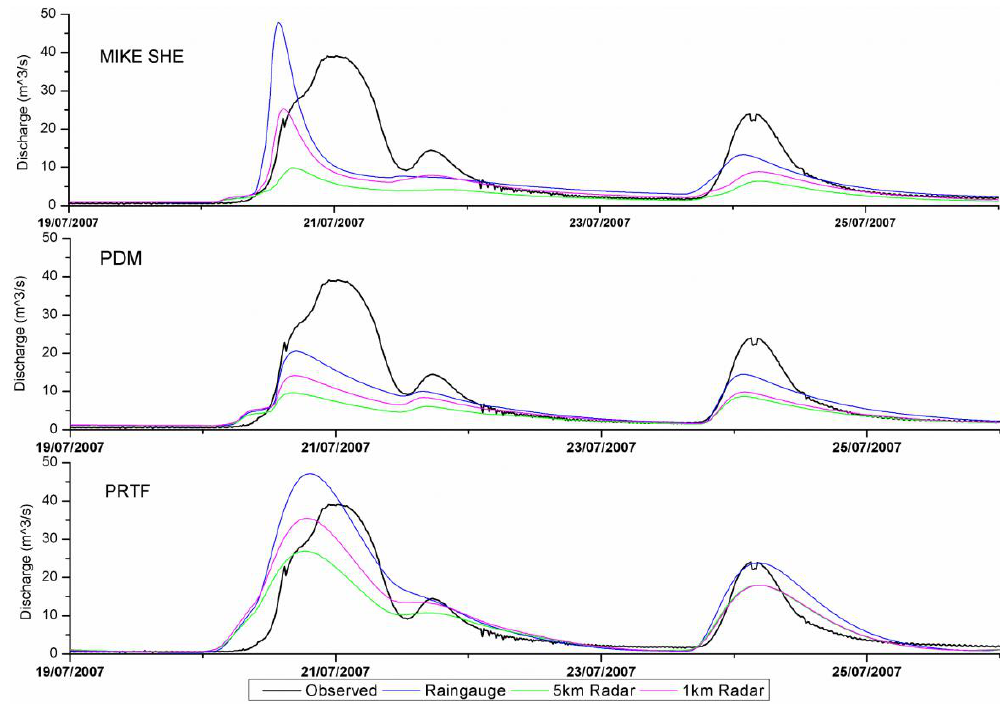
Fig. 11. Model simulations for evaluation period C using raingauge and radar